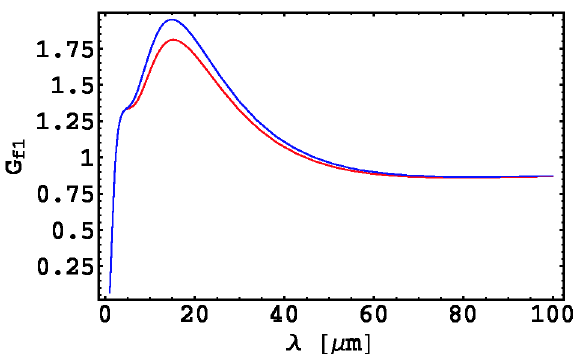
FIG. 1. (Color) BC1 gain G of density modulation as a function of modulation wavelength at the exit of BC1 as calculated from f 1 Eq. (38) with (red) and without (blue) the last term (the two-stage amplification).